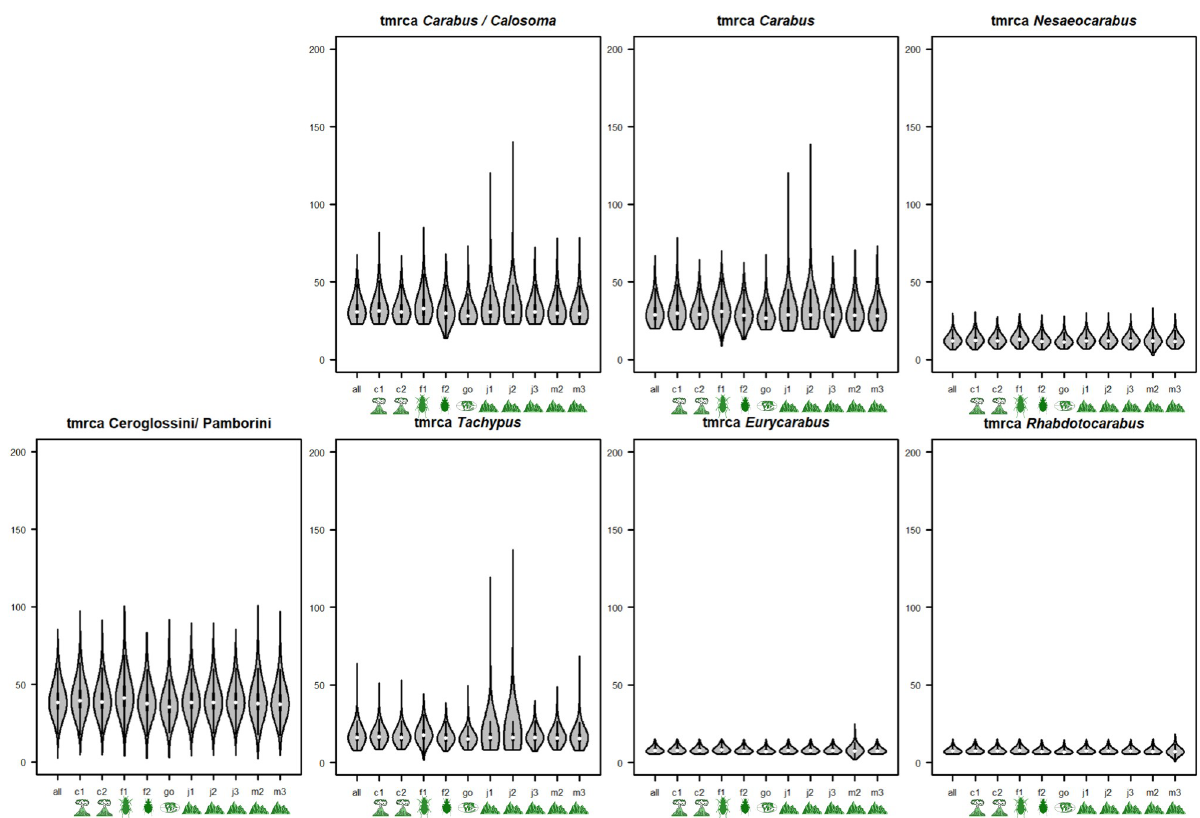
Fig 3. Violin plots of different TMRCA in relation to individual calibration points when root dating is omitted. The plots depict mean (white dots), standard deviation (sd; black bars), 2 � sd (black line), and density distribution (grey shape) of a clade’s age as obtained from the calibration analyses in Fig 1 for each major clade in relation to exclusion of individual calibration points. The x-axis denotes (letter) and depicts (icon) the respectively excluded calibration points in the respective